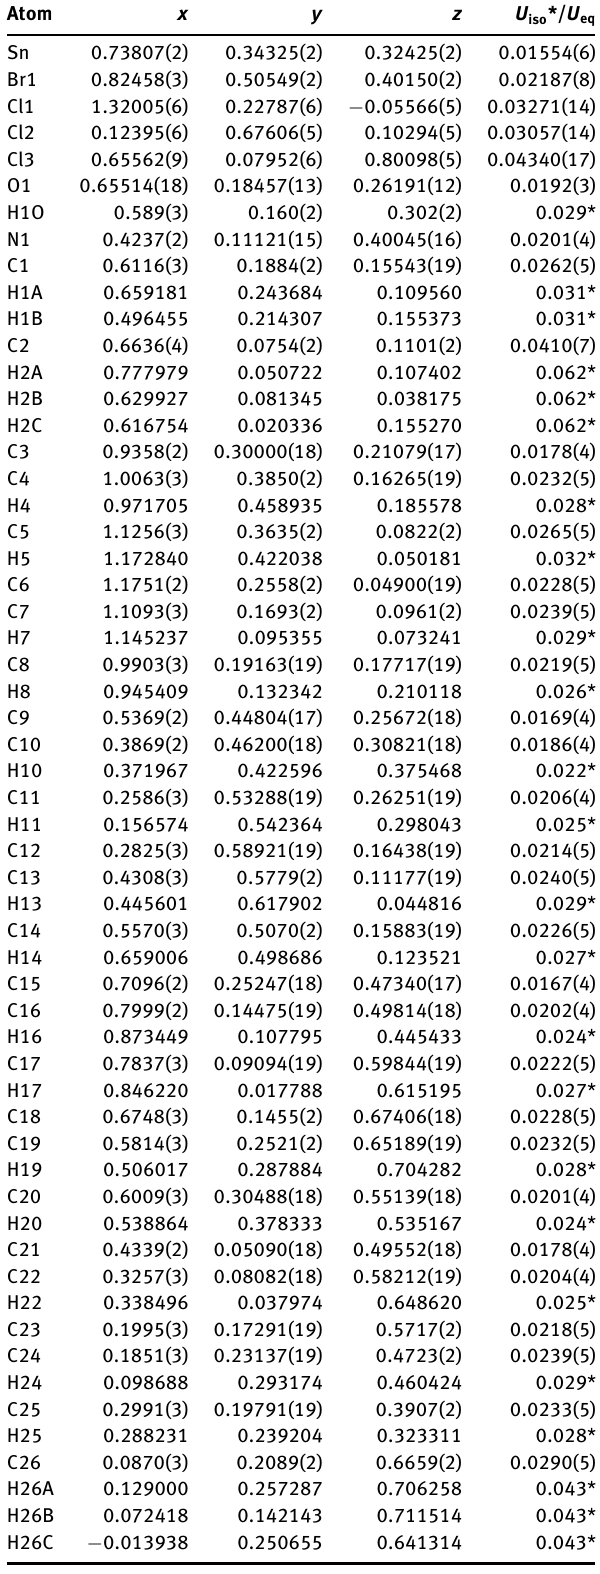
Table 2: Fractional atomic coordinates and isotropic or equivalent isotropic displacement parameters (Å 2